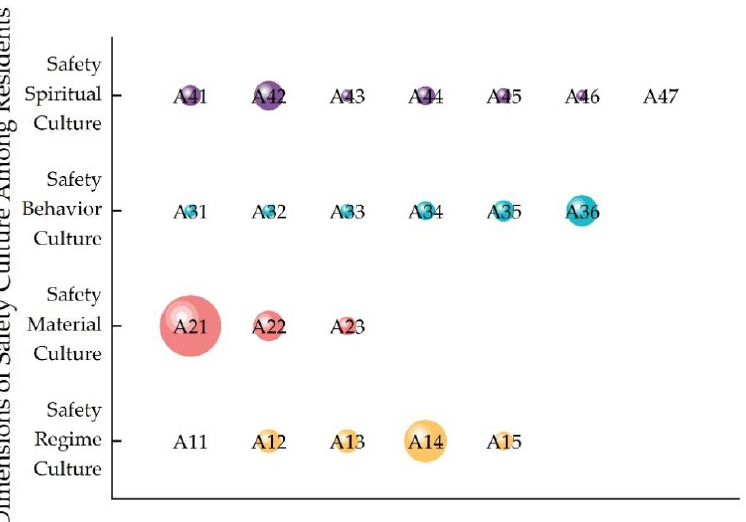
Figure 12. The main obstacle factors of the four dimensions.